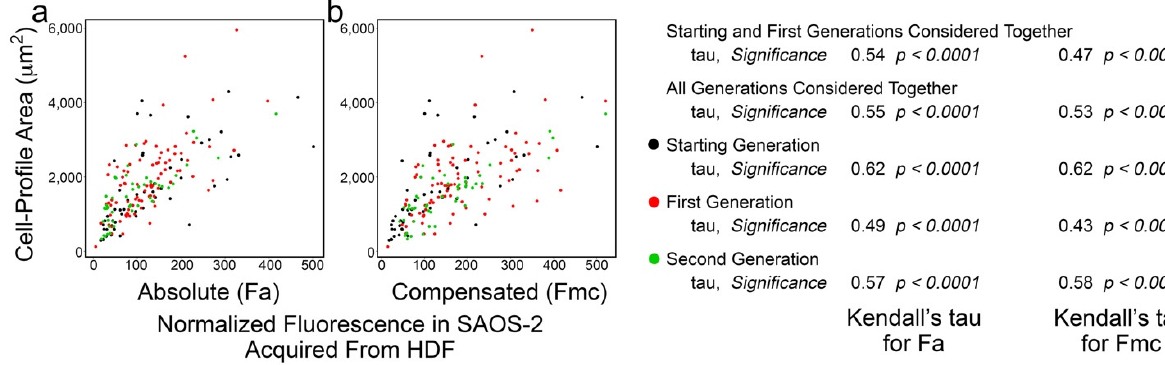
Figure 3. Scatter plots of data from experiment ‘a’ co-culturing SAOS-2 cells with HDFs, showing cell-profile area of co-cultured SAOS-2 cells plotted against normalized fluorescence acquired from HDFs expressed as absolute fluorescence measured (Fa in panel a ), as well as numerical compensation for halving of fluorescence by cell division in mother cells (Fmc in panel b ). The generation to which each cell belonged is indicated by the colour. Values for Kendall’s tau of correlation and their statistical significance are shown for individual generations of cells, starting and first generations together and all generations of cells together. ( a ) There was correlation between cell-profile area and Fa. ( b ) This was reduced for Fmc. Table 1. Kendall’s tau of correlation between cell-profile area of tracked SAOS-2 cells and absolute fluorescence acquired from co-cultured HDFs (Fa), as well as compensation for halving of fluorescence from mother cells by cell division (Fmc). Results for all experiments are shown, considering all generations of cells counted together. Results for other groupings of successive generations of cells are in Supplementary Materials, Table S4.